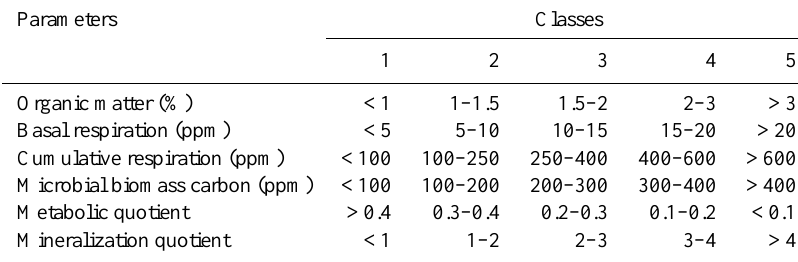
Table 5. Classes of biological parameters: the lower the class, the higher the soil microbiological